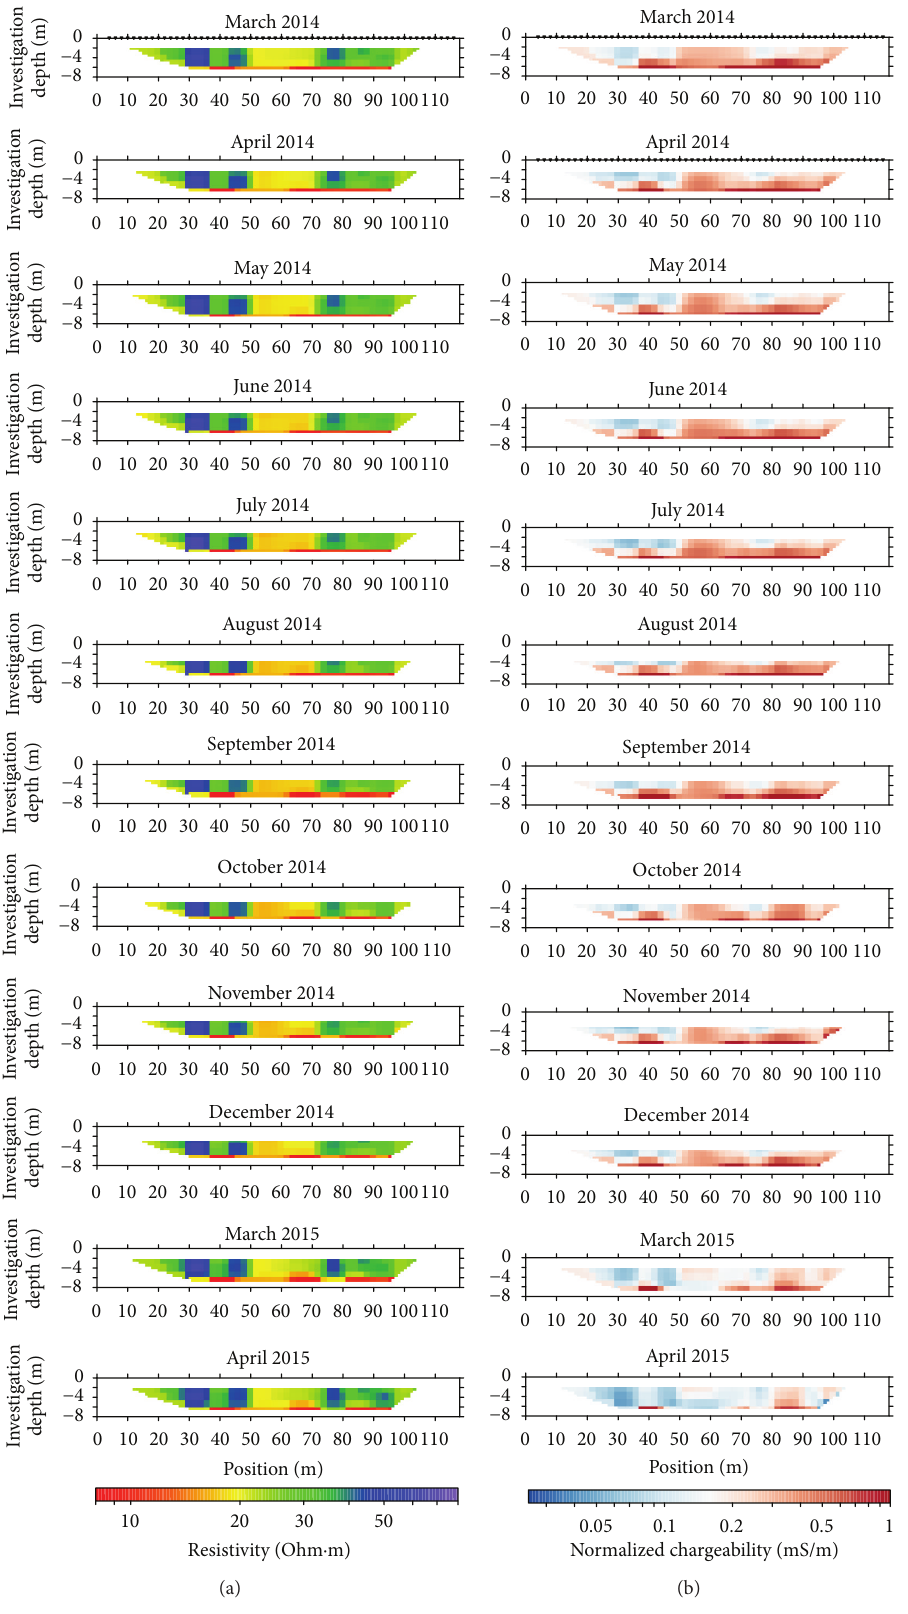
Figure 7: Resistivity (a) and normalized chargeability (b) sections, adjusted at 25 ∘ C in the saturated zone, for the permanent electrical profile, between March 2014 and April 2015. The inversion results were obtained after 5 iterations, with 0.58 and 1.82% of error for resistivity and chargeability,